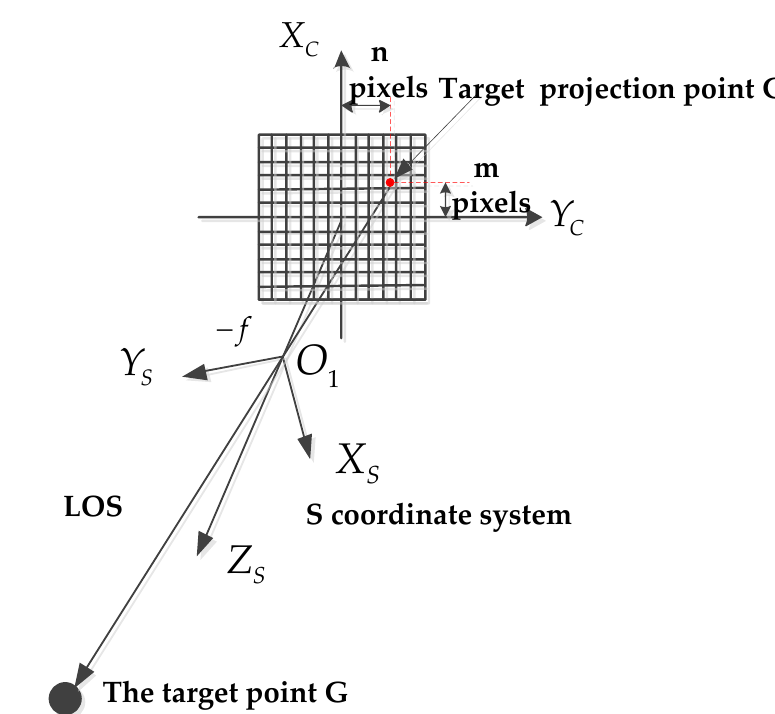
Figure 1. The projection of the target point G on a frame CCD.